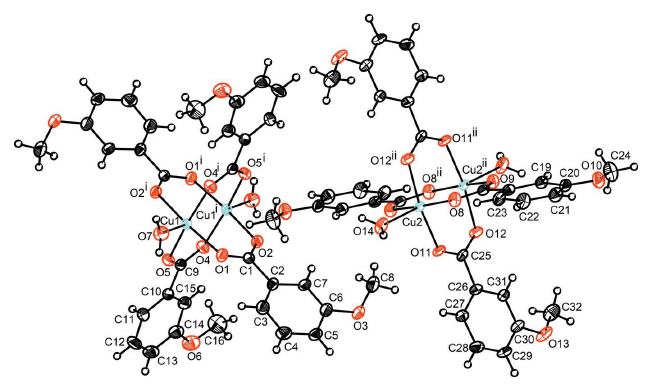
Figure 1 The two centrosymmetric binuclear complexes in the crystal structure of [Cu 2 (C 8 H 7 O 3 ) 4 (H 2 O) 2 ] with displacement ellipsoids drawn at the 30% probability level. [Symmetry codes: (i) (cid:5) x + 1, (cid:5) y + 1, (cid:5) z ; (ii) (cid:5) x + 2, (cid:5) y + 1, (cid:5) z +